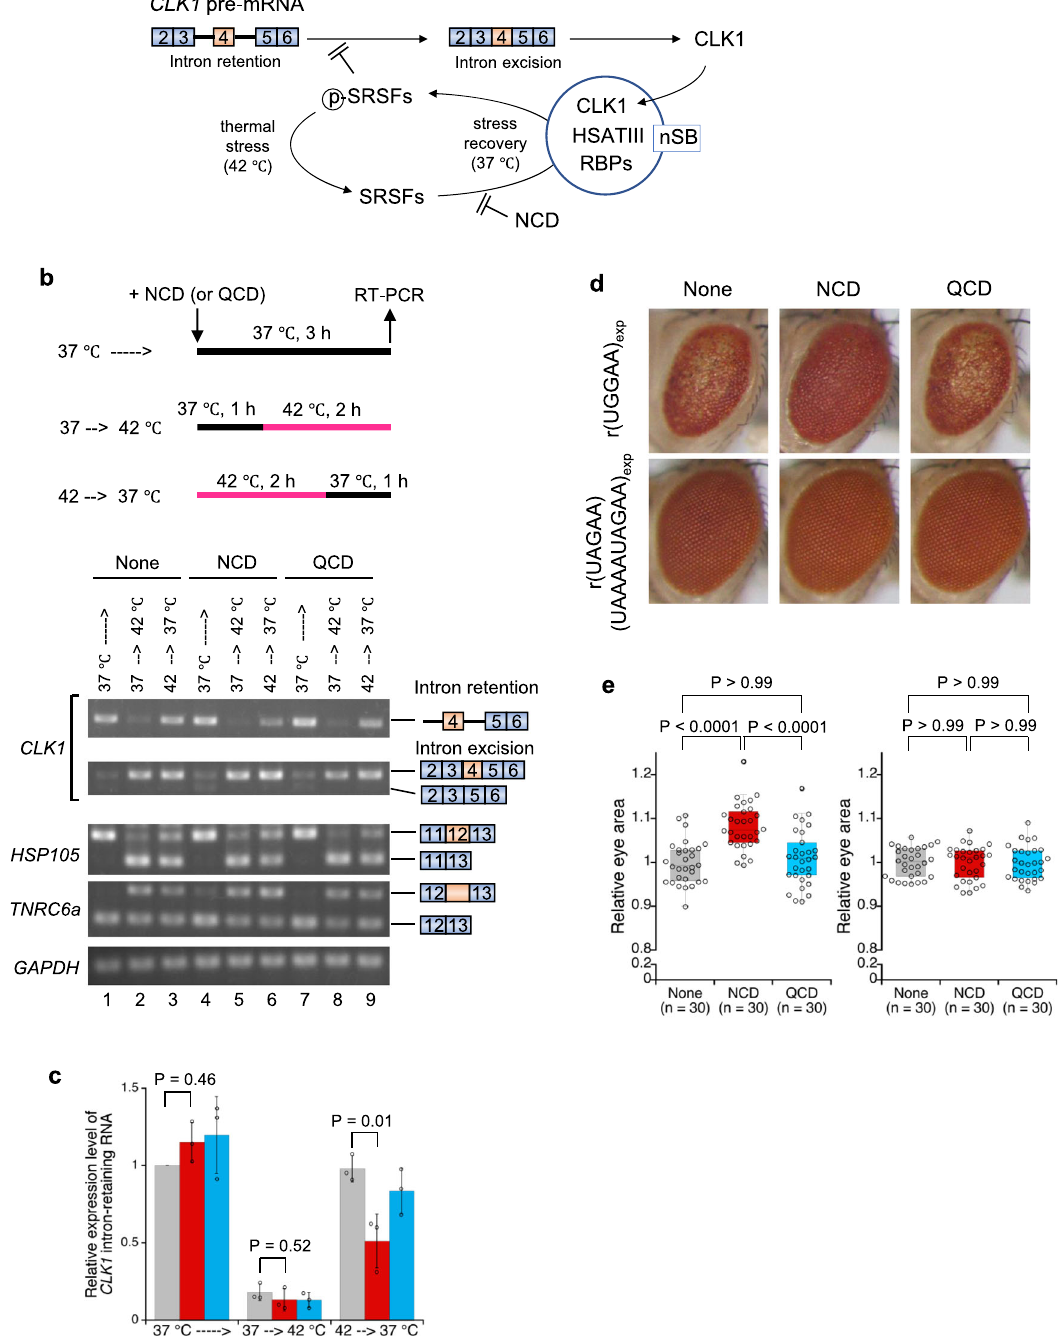
Fig. 6 Biological activity of NCD in splicing and SCA31 disease models. a Schematic illustration of nSB-dependent intron retention through re- phosphorylation of SRSFs. b Semi-quantitative RT-PCR analysis of CLK1 intron-retaining pre-mRNA during thermal stress recovery. The GAPDH mRNA was used as an internal control. c Relative expression level of the CLK1 intron-retaining pre-mRNA in the absence (gray) and presence of 2.5 μ M NCD (red) and QCD (blue). Data are shown as the mean ± SD ( n = 3 independent experiments); (Dunnett ’ s multiple comparison test, two-sided). d Light microscopic images of compound eyes from Drosophila expressing r(UGGAA) exp ( GMR - Gal 4/ + ; UAS -( UGGAA ) exp / + ) ( upper, left ) and r(UAGAA)(UAAAAUAGAA) exp ( GMR - Gal 4/ + ; UAS -( UAGAA )( UAAAAUAGAA ) exp / + ) ( lower, left ) with the administration of NCD (middle) and QCD (right). Ligand concentration was 100 μ M. e Box plots of the eye area of Drosophila expressing r(UGGAA) exp (left) and r(UAGAA)(UAAAAUAGAA) exp (right) ( n = the number of the analyzed fl ies). Box plots show median (center line), upper, and lower quartiles (upper and lower box limits), upper quartiles + 1.5× interquartile range (upper whiskers), and lower quartiles – 1.5× interquartile range (lower whiskers). p -value (Kruskal – Wallis test, followed by Dunn ’ s multiple comparison test, two-sided) was shown above. Source data are provided as a Source Data fi